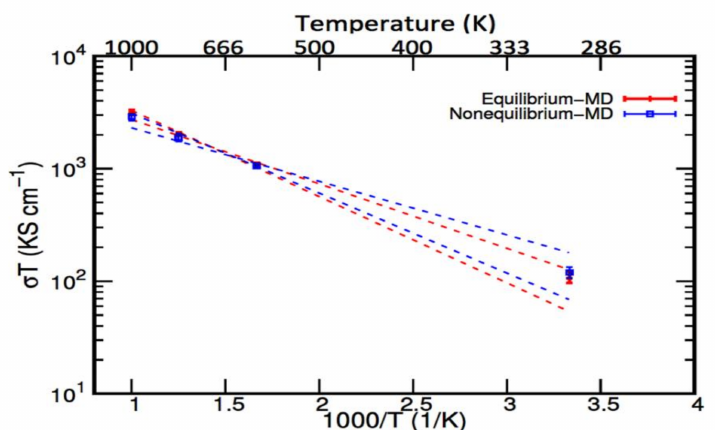
Figure 4. Arrhenius plot for Li 5 PS 4 Cl 2 conductivity. Outcomes of AI–EMD simulations and AI– NEMD simulations at specific temperature. The error ranges for extrapolation estimated data at 600 K and 800 K to 300 K are displayed by AI-EMD and AI-NEMD, respectively. Adapted from Baktash et al.